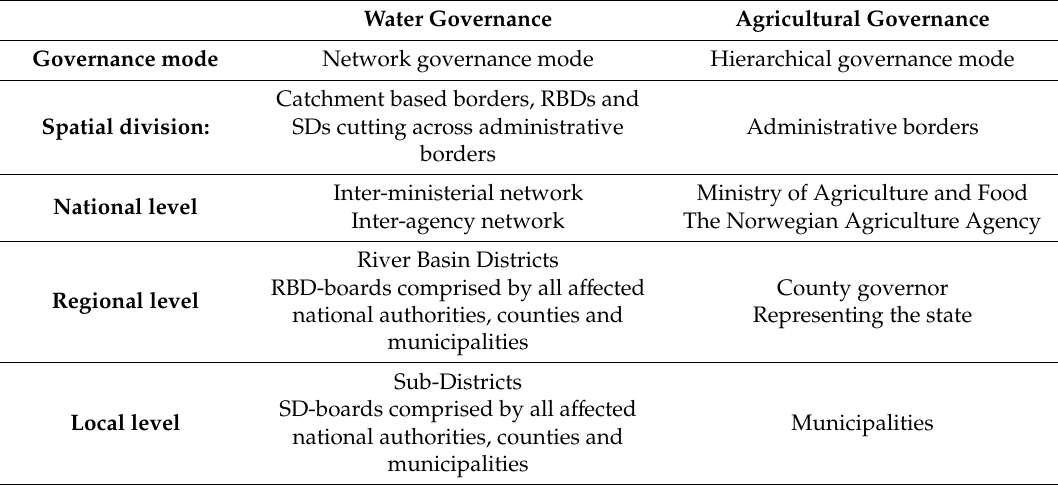
Table 1. The water governance structure and agricultural governance structure in